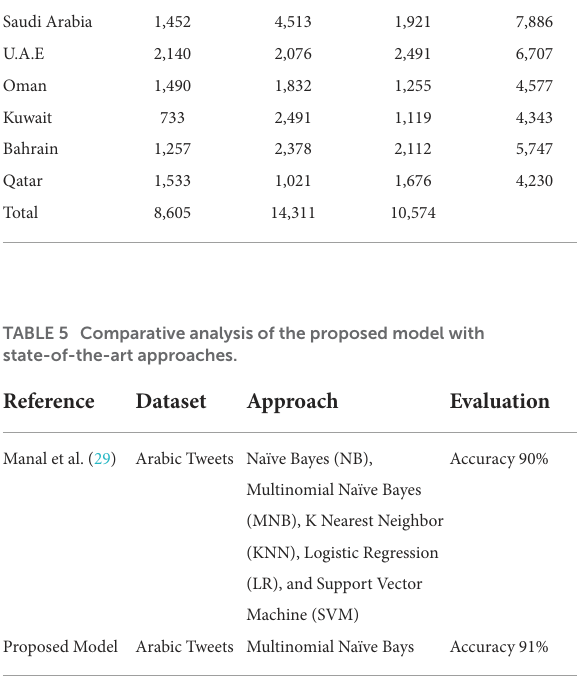
TABLE 4 The results of Sentiment Analysis in Gulf Countries during the COVID-19 pandemic. Country